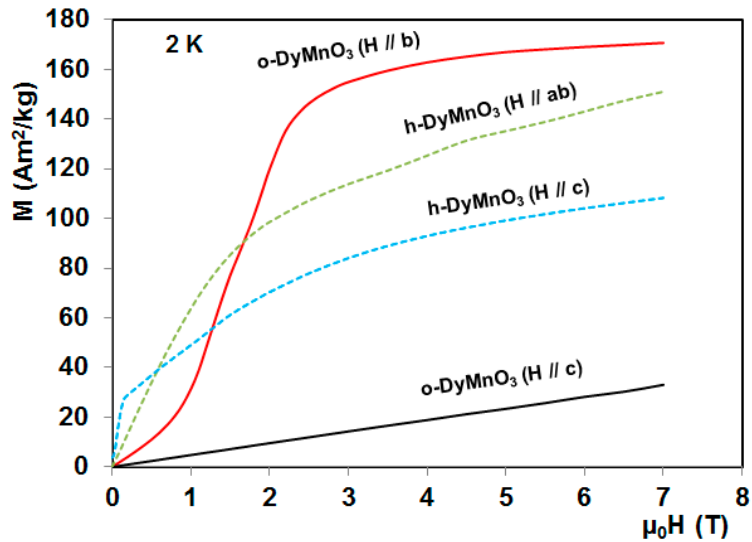
Figure 5. Isothermal magnetization curves at 2 K for orthorhombic ( o ) and hexagonal ( h ) DyMnO 3 single crystals along their easy and hard-orientations [22,24].